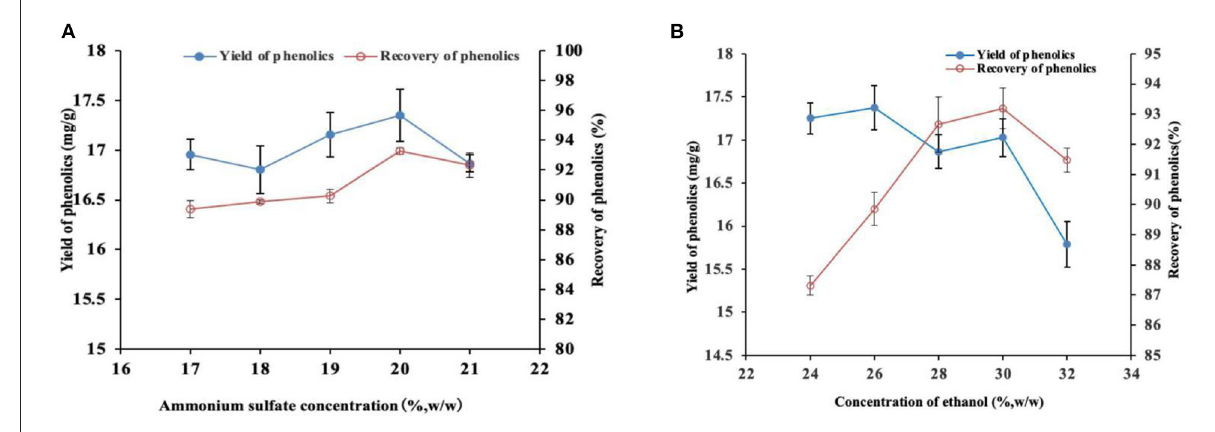
FIGURE2 Effect of different ammonium sulfate (A) and ethanol (B) concentrations on the yield and recovery of